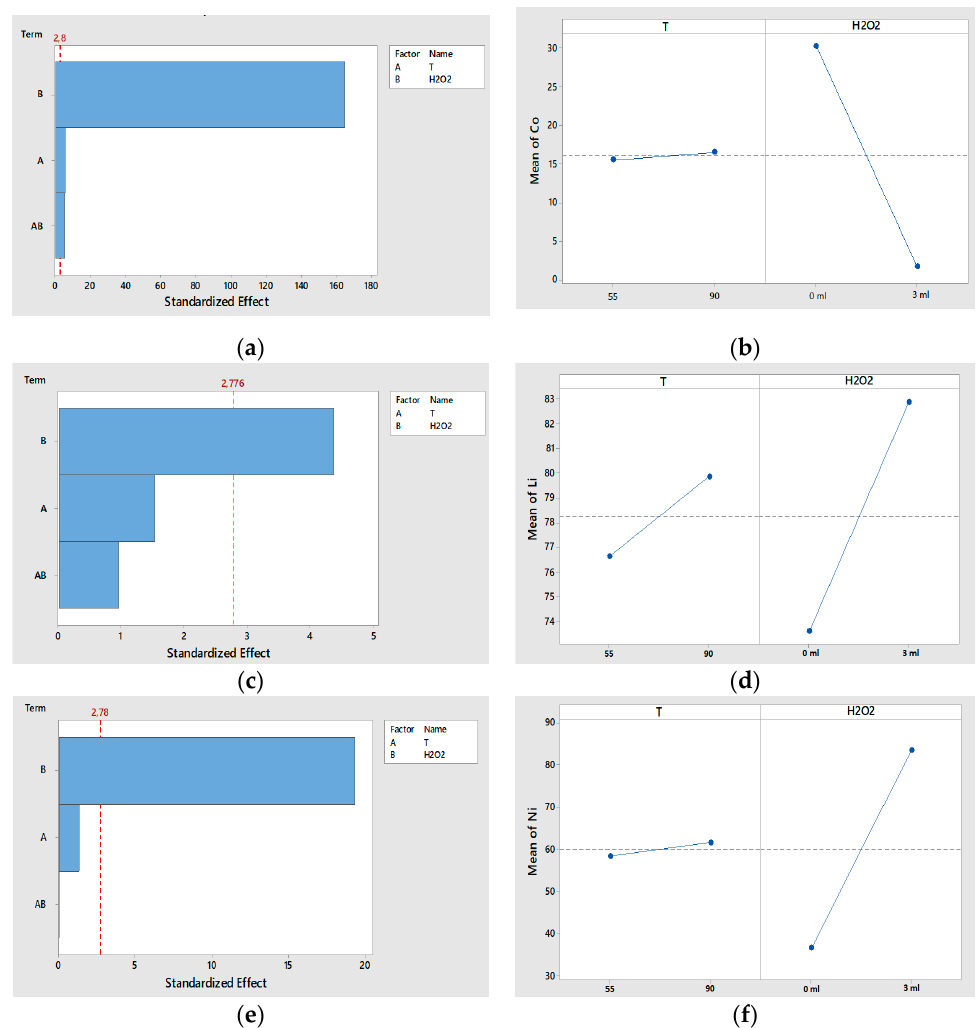
Figure 3. Factors influencing the conducted leaching process. ( a ) Pareto Chart of the standardized effects–Co; ( b ) main effects plot–Co; ( c ) Pareto Chart of the standardized effects–Li; ( d ) main effects plot–Li; ( e ) Pareto Chart of the standardized effects–Ni; ( f ) main effects plot–Ni.